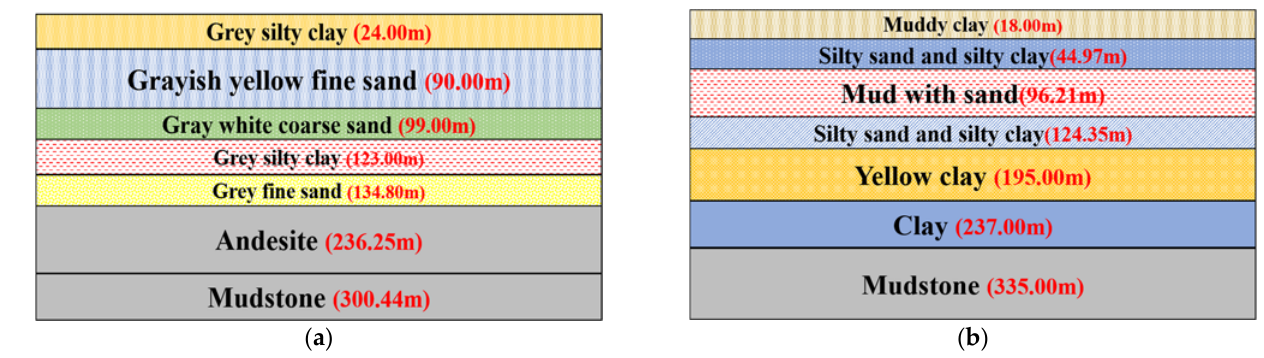
Figure 7. Shanghai geological planing surface map. (Borehole ( a ) is shown on the left, borehole ( b ) is shown on the right, and red number indicates the bottom burial depth. The color is Quaternary Geology and the gray is deep bedrock)